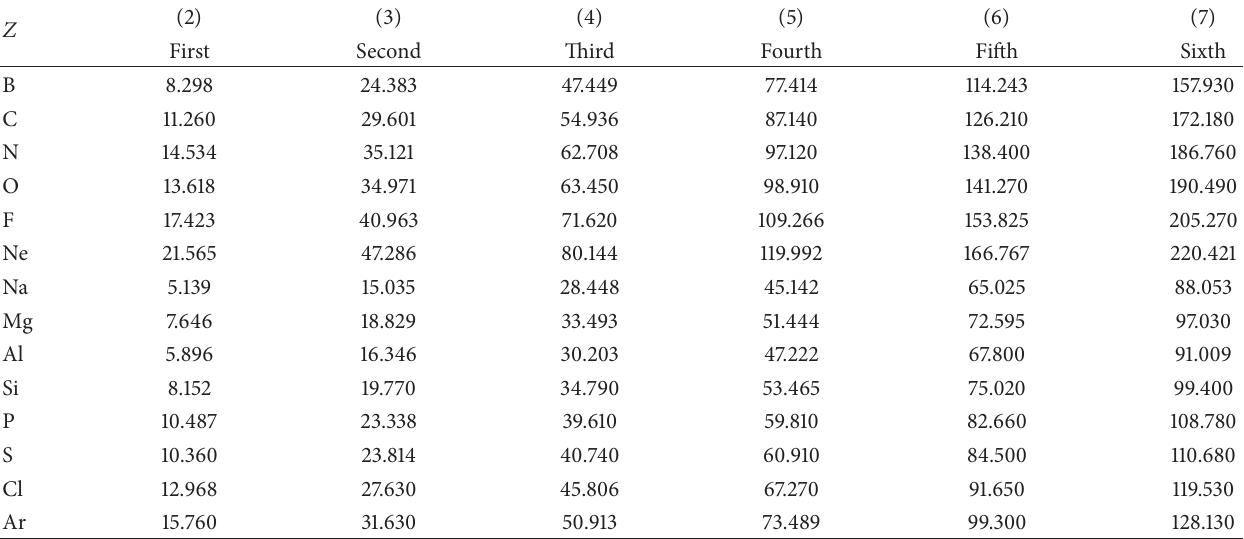
Table 3: Ionization energies (eV) of isoelectronic series from the CRC Handbook (5 to 18 electron sequences)—first six members of each series.